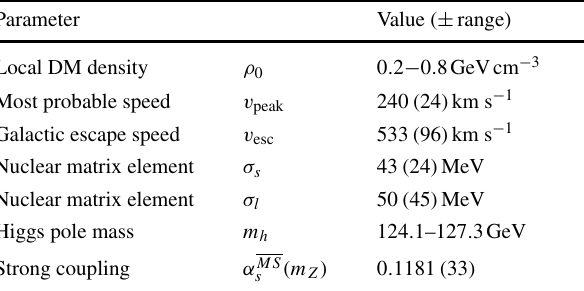
Table 2 Nuisance parameters that are varied simultaneously with the DM model parameters in our scans. All parameters have flat priors. For more details about the nuisance likelihoods, see Sect.